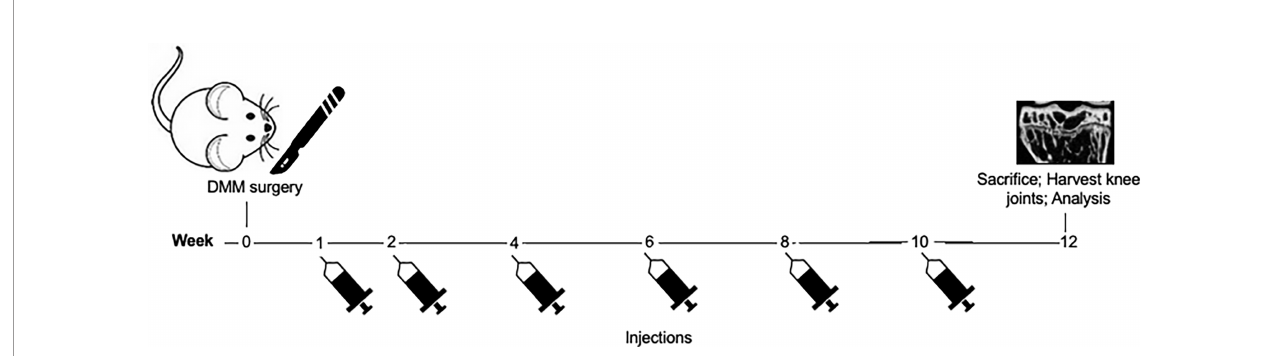
FIGURE 2 | Schematic showing the protocol for treatment following DMM surgery. Knee surgery (sham or destabilization of medial meniscus) was performed on day 0. Intra-articular injections of either PBS (control), CD200Fc, or CCS13 were given in the healing joint at weeks 1, 2, 4, 6, 8, and 10. All mice were sacri fi ced at week 12 and the healing knee joints were analyzed via histology and microCT